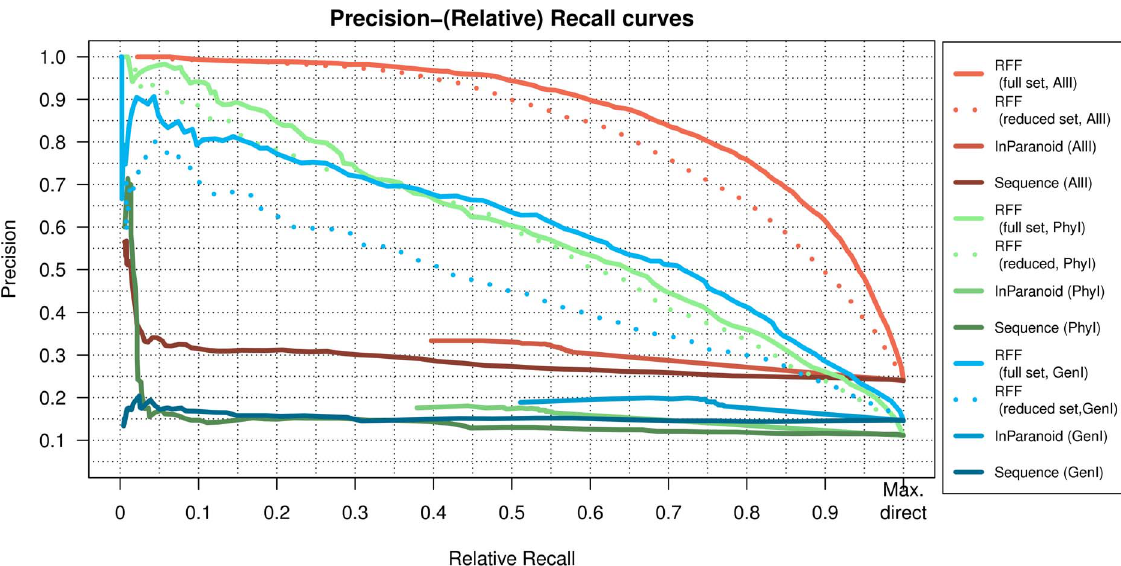
Figure 2. Precision - (relative) Recall curves. Precision - (relative)Recall curves for the RFF (Random-Forest-Filter) trained with the reduced feature set, the full feature set and different experimental setting (only physical interactions ( PhyI ), only genetic interactions ( GenI ) and all interactions ( AllI )) using 10-fold cross validation. Interactions are transferred from all eukaryotic species with interaction data to S. cerevisiae and filtered with the respective approaches. In addition, the precision and relative recall is given for a simple sequence similarity filter and a filter based on the InParanoid ortholog bootstrap score. The RFF for AllI trained with the full (red) and reduced (red dotted) feature set perform best. The reduced feature set performs somewhat worse than the full feature set. For the more strict PhyI and GenI settings in which also the type of an interaction is transferred, the performance drops in comparison to AllI . By comparing the different feature sets it can be seen that for physical interactions (green, green dotted) almost the same performance for the full and reduced feature set can be reached, whereas for genetic interactions (blue, blue dotted) a clear difference in the performance can be observed. But again, for these two settings a huge improvement of RFF to the baseline filters based on sequence similarity) and ortholog scores can be